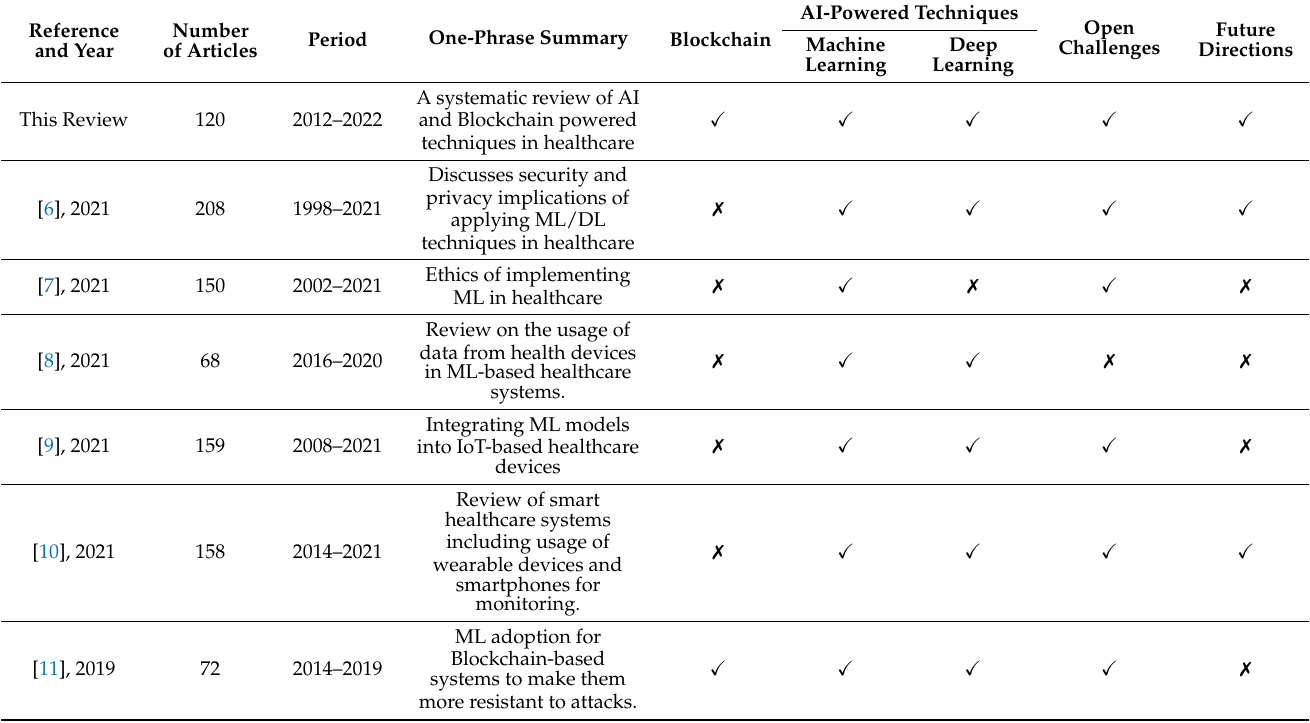
Table 2. Comparison with other similar review